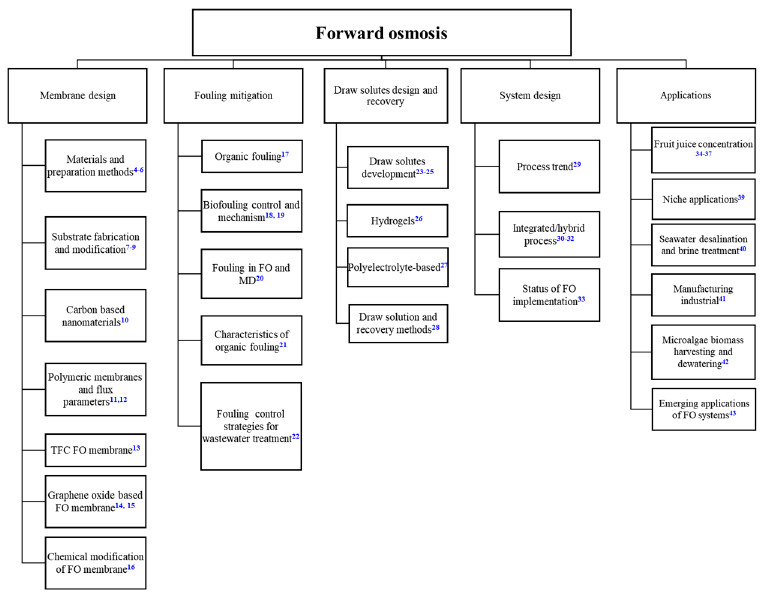
Figure 1. The focus of FO review papers published from 2018–2022. The number in the upper-right indicates the corresponding reference.